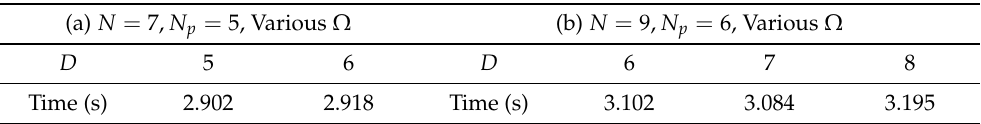
Table 3. CPU Running Time (SNR = 15 dB, K =